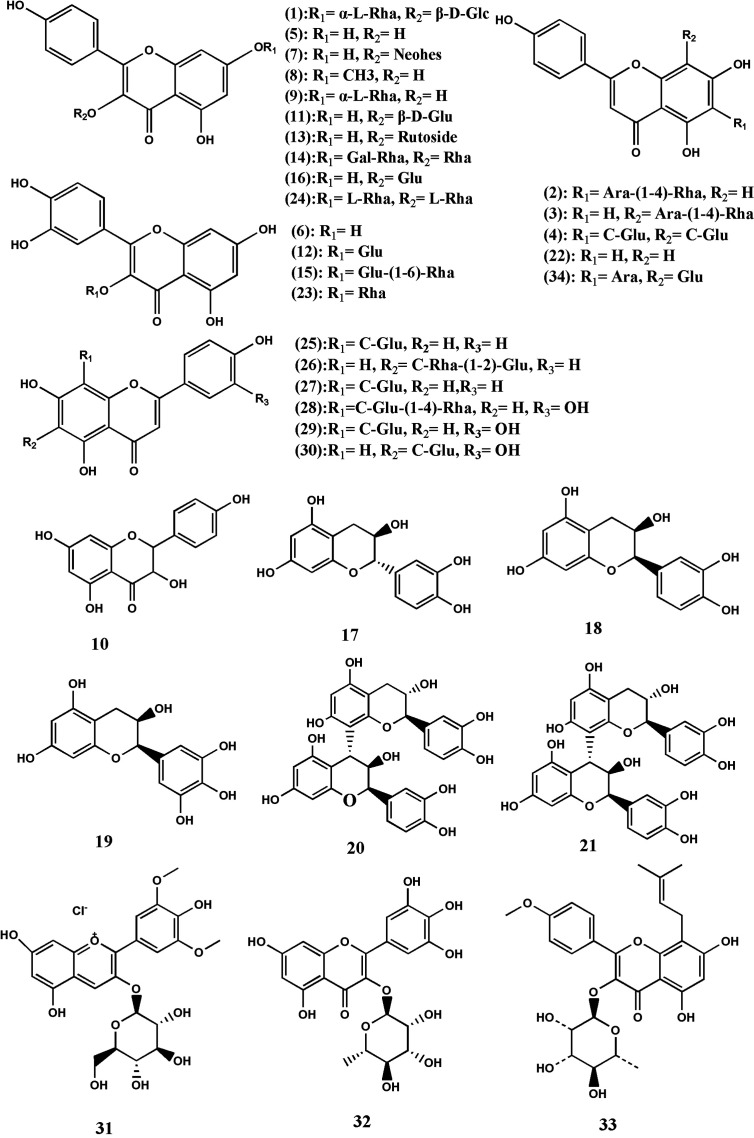
Structures of the flavonoids from Tetrastigma hemsleyanum Diels & Gilg.